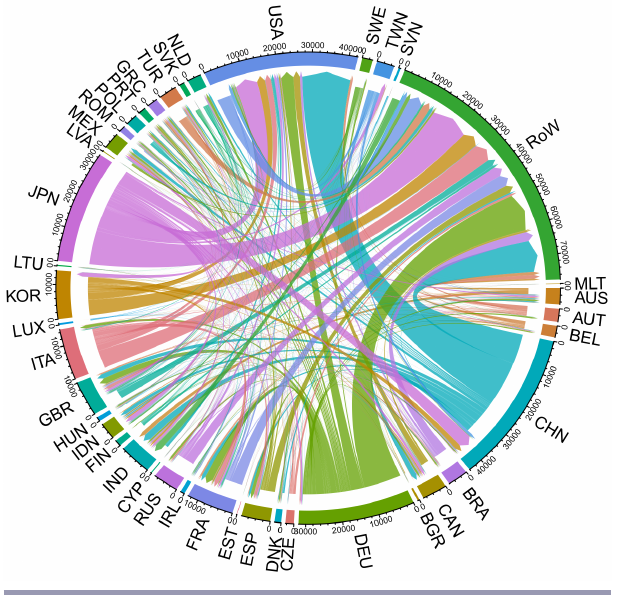
Fig. 3 . Flows of value added exports (VAX) in metal products trade worldwide. Country codes are specified in Table